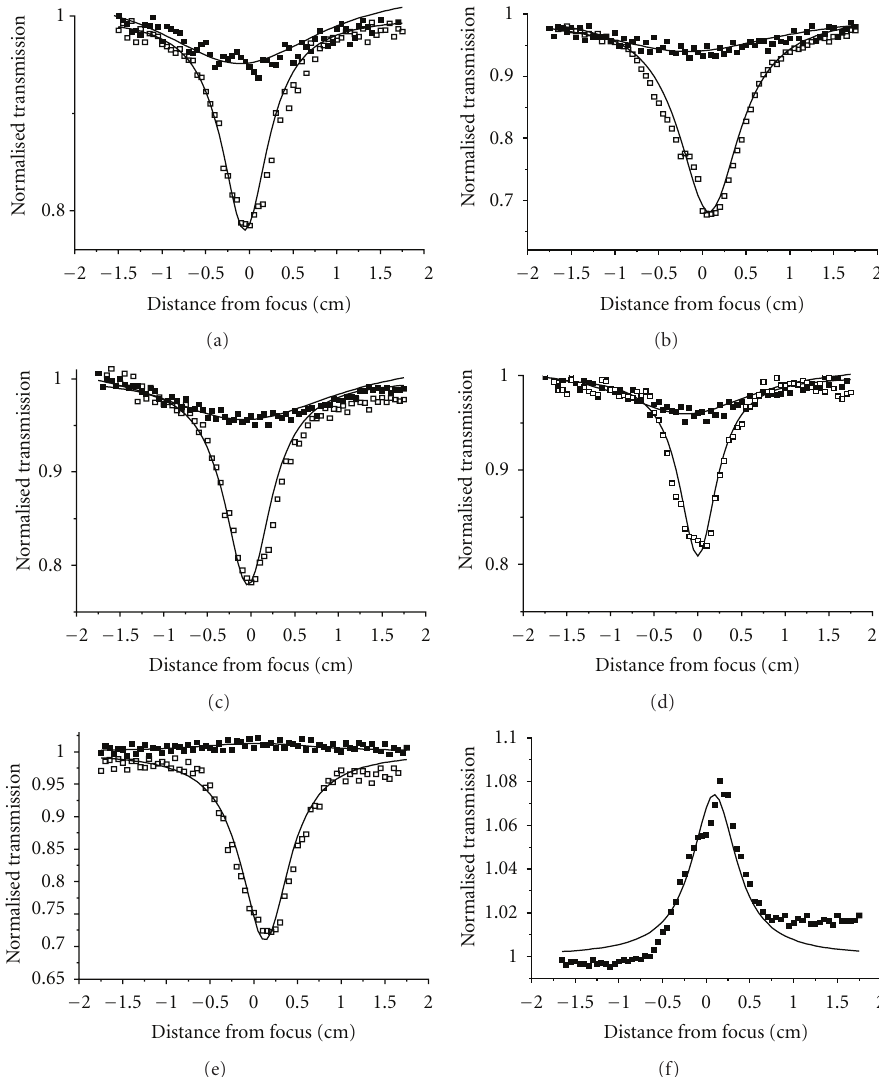
Figure 5: Plots of normalised transmission versus distance from focus for porphyrin and composite solutions at low energies for (a) DETPP, (b) tTETPP, (c) cTETPP, (d) HETPP, and (e) OETPP. (f) The higher final transmittance compared with the initial transmittance indicates the destruction of molecules present in the solution. Porphyrin and composite solutions were at concentrations of 0.01 mg/mL, with onfocus intensities of (a) 0.12, (b) 0.13, (c) 0.14, (d) 0.25, (e) 0.23, and (f) 1.63575 GW/cm 2 for porphyrin solutions and (a) 0.25, (b) 0.16, (c) 0.24, (d) 0.23, and (e) 0.19 GW/cm 2 for composite